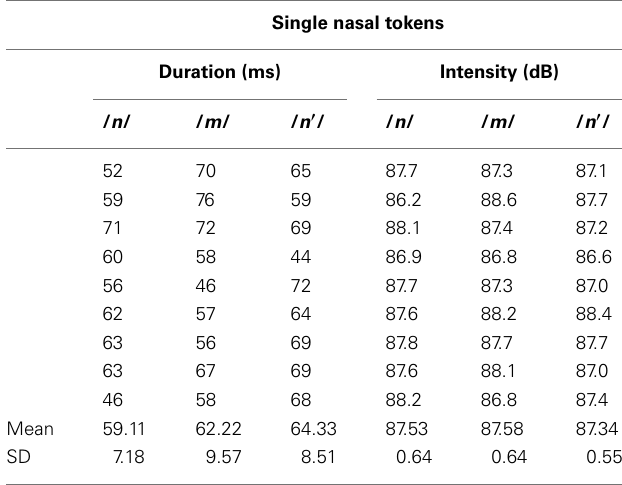
TableA2 | Duration and intensity of the selected 27 tokens of prototypical / n /, / m /, and / n (cid:48)